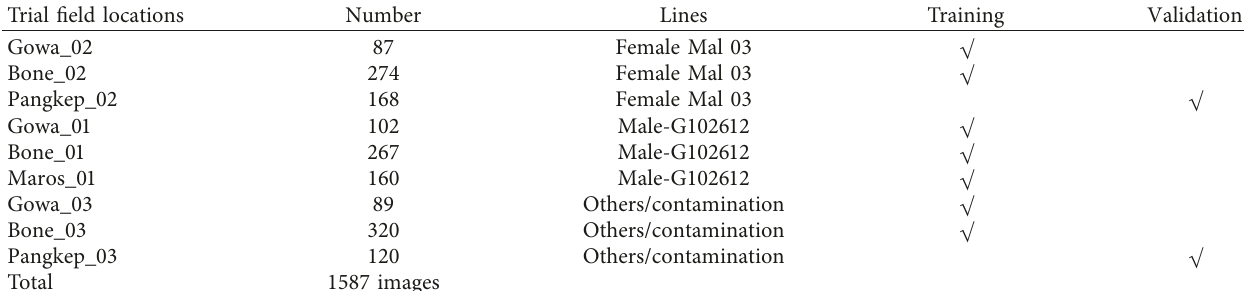
Table 1: Maize tassel datasets used for the case study.